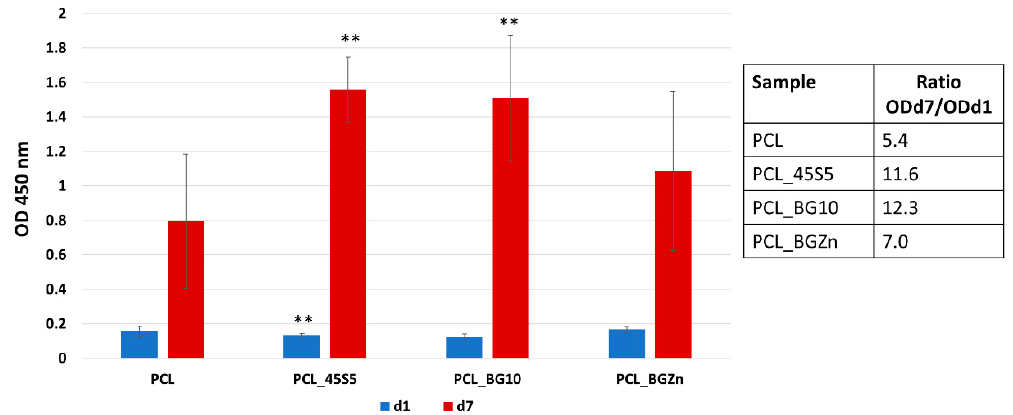
Figure 7. WST–8 analysis: graph of OD at 450 nm for all electrospun mats 1 day and 7 days after seeding. ** p < 0.05 (one-way ANOVA) and a table reporting the ratio ODd7/ODd1.